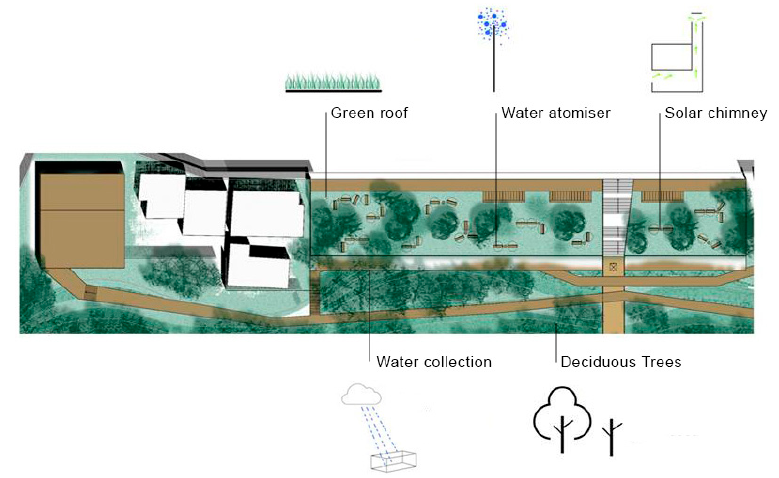
Figure 15. Case study no. 3, Porta Solestà.